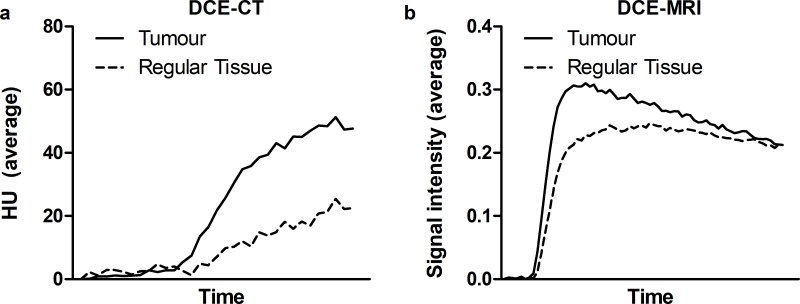
Average time curves of contrast uptake in PCa versus healthy regular prostate tissue.(A) Dynamic contrast-enhanced computed tomography (DCE-CT) and (B) dynamic contrast-enhanced magnetic resonance imaging (DCE-MRI), depicted for tumors in the peripheral zone. HU, Hounsfield Units.